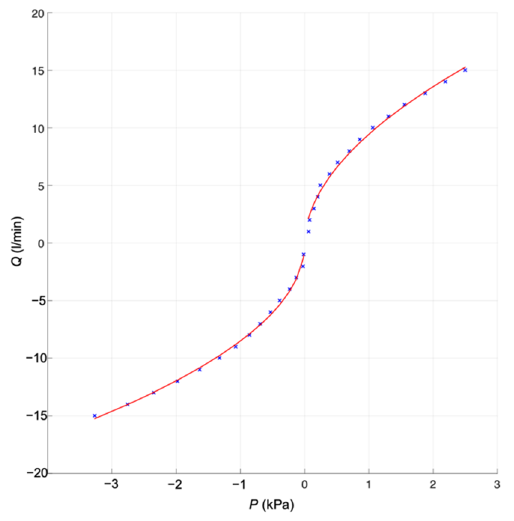
Figure 5. Pressure-flow characteristic of the orifice plate